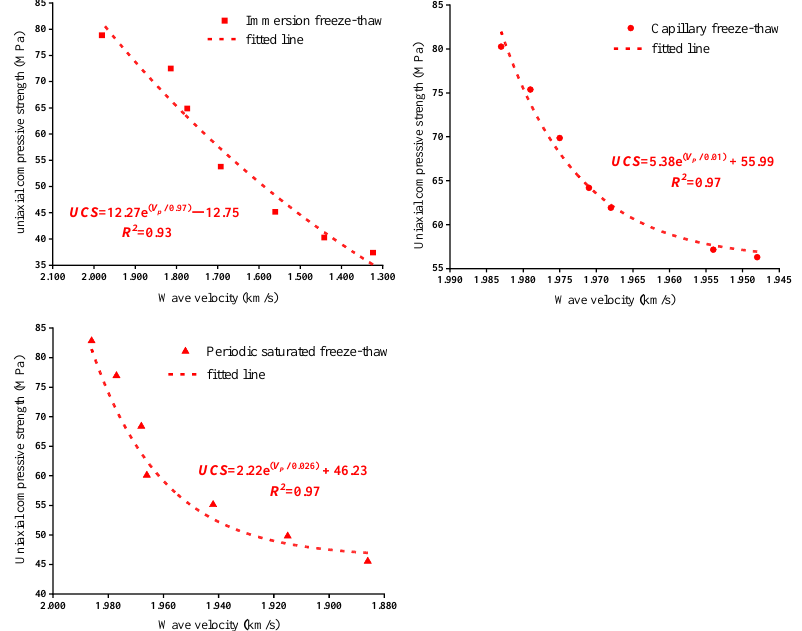
Figure 15. Correlation curve between wave velocity and UCS of rock samples.